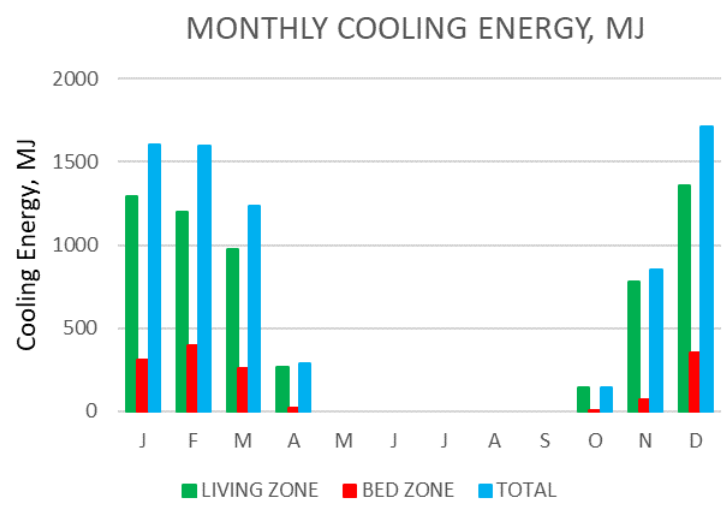
Figure 9. Monthly cooling energy for living room and bedrooms, and the total (normal operation).